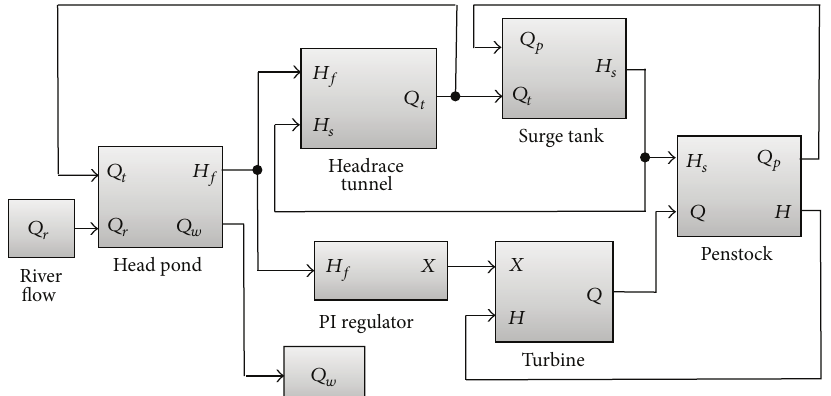
Figure 2: Block diagram of the control